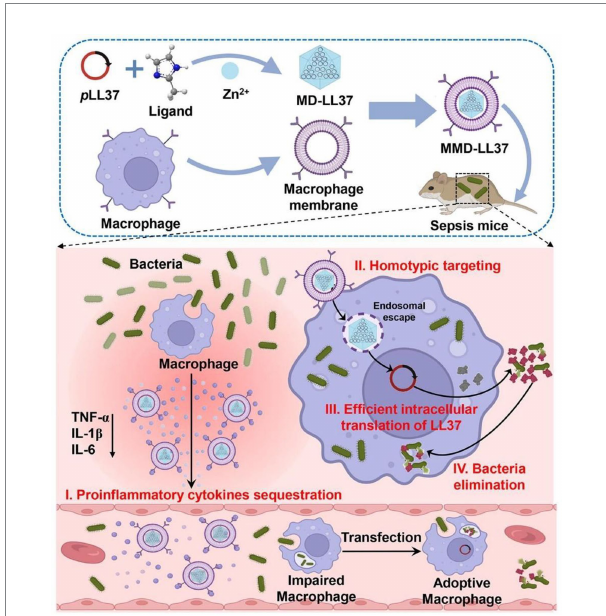
FIGURE 4 Schematic illustration of the application of macrophage membrane- coated metal–organic framework (MOF) for pLL37 delivery (MMD- LL37) and sepsis therapy. The constructed MMD-LL37 can sequester pro-inflammatory cytokines, realize the targeted delivery of plasmid, generate antibacterial LL37, and eradicate bacteria in circulation and those hidden inside cells. Reproduced with permission (Cao et al., 2022; Copyright© 2022, American Chemical